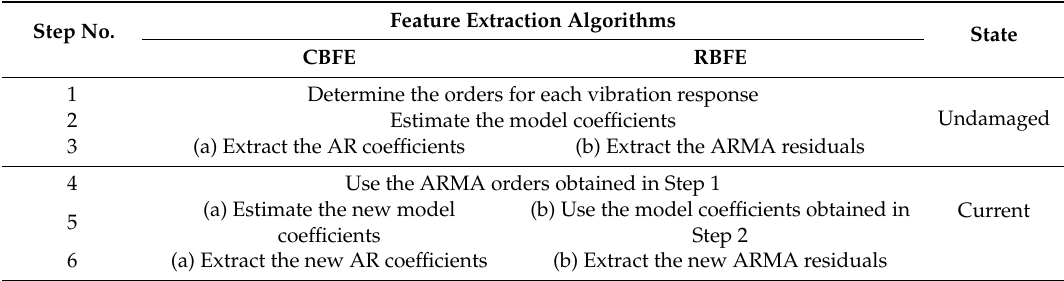
Table 1. Steps of the coe ffi cient-based feature extraction (CBFE) and residual-based feature extraction (RBFE) algorithms based on autoregressive moving average (ARMA)